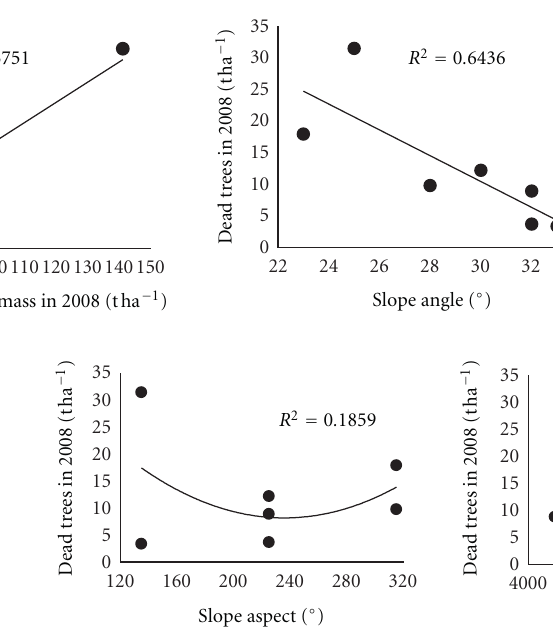
Figure 4: Simple regression analysis of dead tree biomass (2011) at the stand level versus stand characteristics in 2008. Table 4: Biomass distribution in di ff erent DBH classes for the seven plots in 2008. DBH classes (cm)